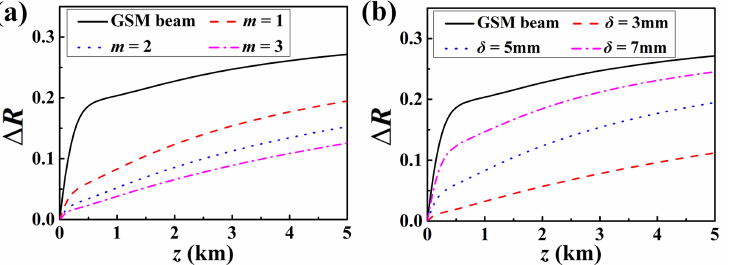
Figure 8. Relative radius of curvature of SSS beams traversing through oceanic turbulence for various ( a ) beam orders and ( b ) coherence